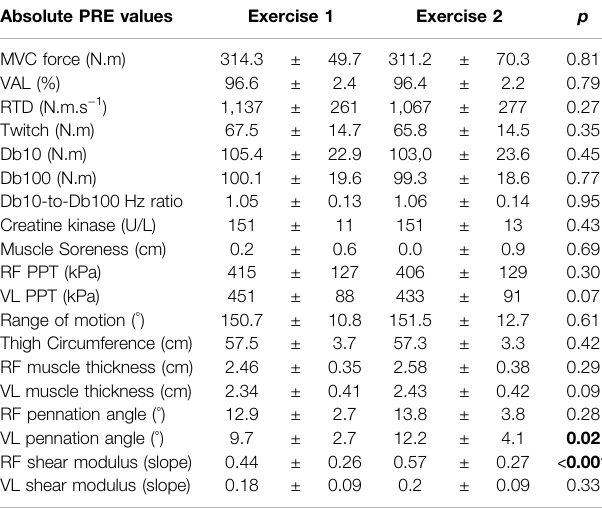
TABLE 1 | Absolute PRE values of Exercise 1 and Exercise 2 for all parameters. MVC: maximal voluntary torque; VAL: voluntary activation level; RTD: rate of torque development; Db10: doublet at 10 Hz; Db100: doublet at 100 Hz; RF: rectus femoris ; VL: vastus lateralis ; PPT: pain pressure threshold. Results with a p -value < 0.05areconsideredsigni fi cantandaredisplayedinboldcharacters. Absolute PRE values Exercise 1 Exercise 2 p MVC force